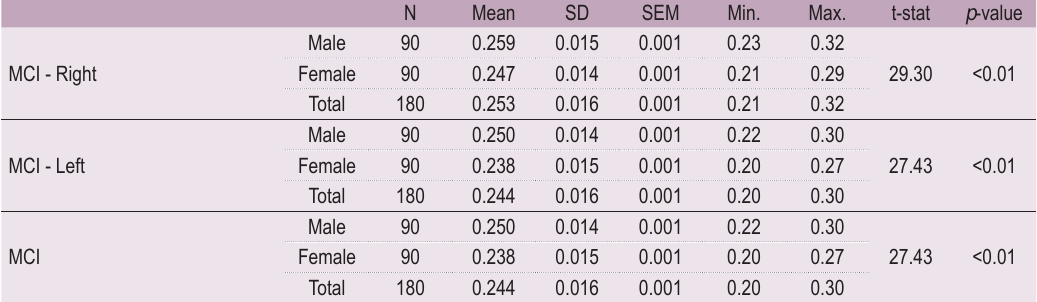
TABLE 2. Standard Mandibular Canine